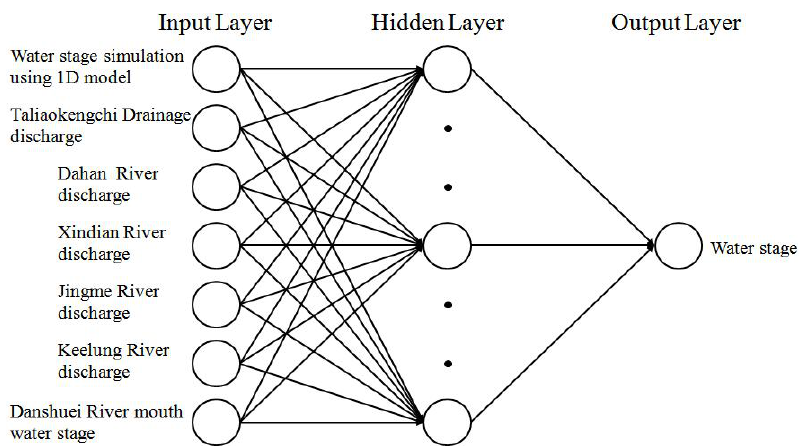
Figure 5. BPNN structures for predicting the water